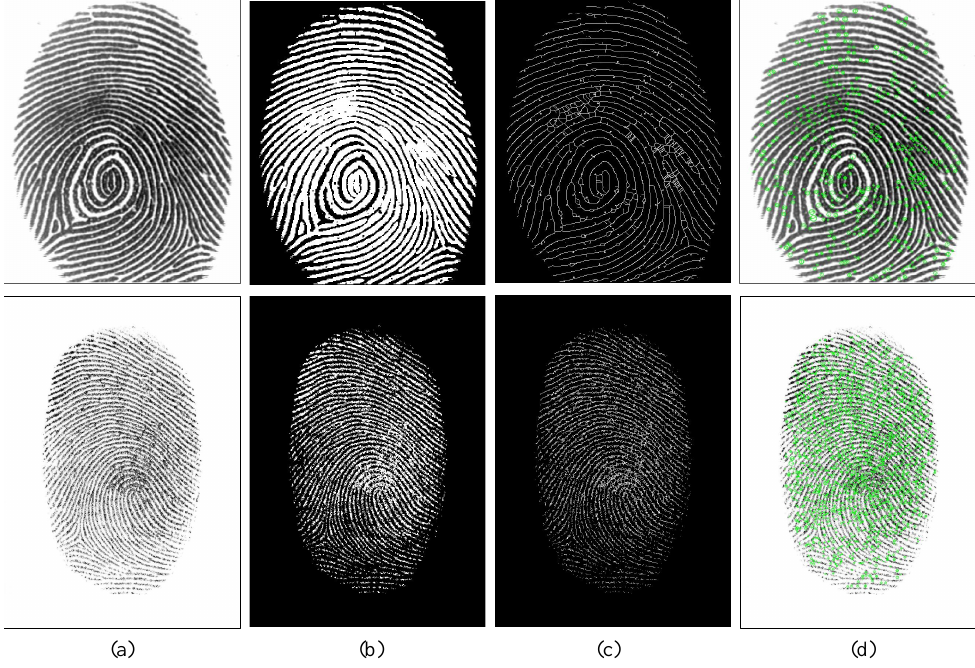
Figure 8. SIFT minutiae feature detection ( a ) original image, ( b ) binary image, ( c ) thinned image, and ( d ) detected SIFT minutiae keypoints (pixels shown in green